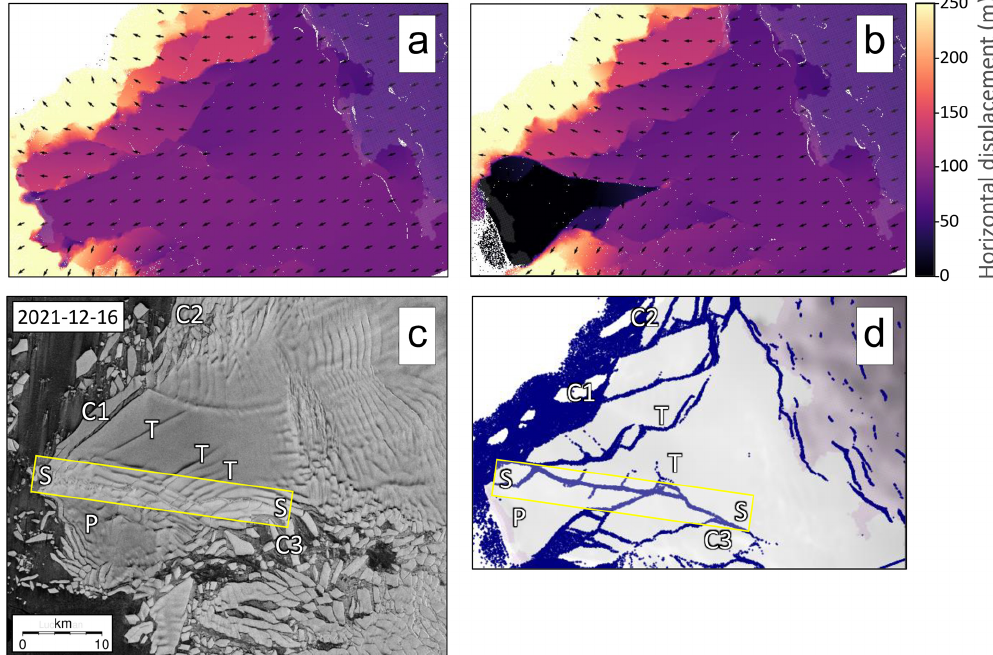
Figure 8. Modelled and observed fractures on TEIS. Panels (a) and (b) show ice displacement patterns simulated in HiDEM. Panel (c) shows the satellite observations and labels key features as in Fig. 3 (S–S: TEIS shear zone; T: tensile cracks; C1–C3: calving along rifts; P: pinning point). Panel (a) illustrates that the observed shear zone does not develop in the simulation with the baseline friction boundary condition over the pinning point (i.e. values derived from the Elmer/Ice inversion rescaled for HiDEM) and damage density = 0 . 6. The zone of large displacements around TEIS (yellow) consists of mélange and calved icebergs. Panel (b) shows the sharp displacement gradient (shear zone) between the main body of TEIS and the triangular area of stationary ice extending from the pinning point in the HiDEM simulation with a no-slip boundary condition over the pinning point and damage density = 0 . 6. Panel (d) illustrates fracture patterns resulting from the HiDEM simulation, depicting surface elevation in greyscale shading and bonds broken during the simulation in blue. Features with close correspondence to the observations are also